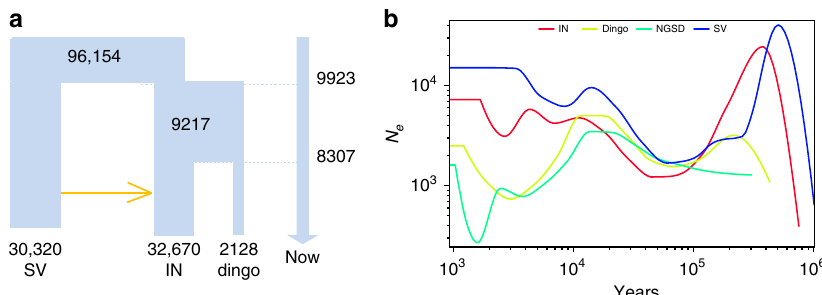
Fig. 2 Demographic history of dingoes and dogs from southern East Asia. a Demographic history inferred for indigenous dogs from southern China (SV), Indonesian village dog (IN) and dingo using G-phocs. b Inferred effective population sizes over time for indigenous dogs from southern China (SV), Indonesian village dog (IN), dingo and NGSD using SMC ++